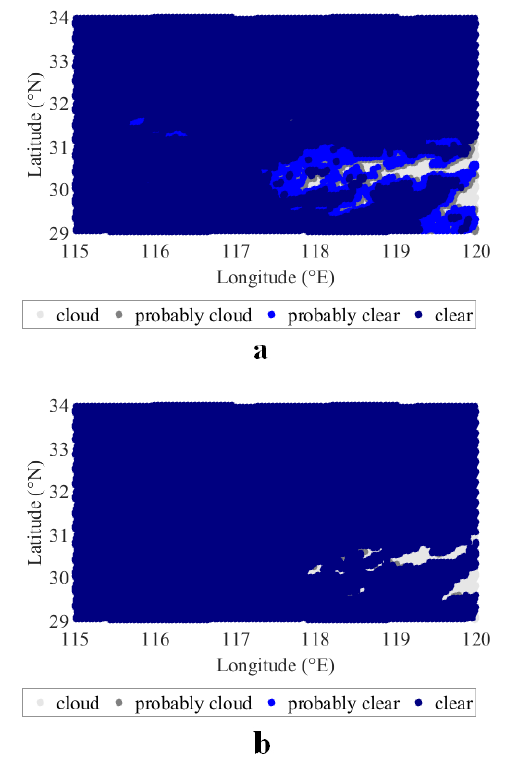
Figure 9. Cloud detection image at UTC 20181005000000. Figure a is the CLM product of FY-4A, and Figure b is the detection result of the decision tree cloud detection